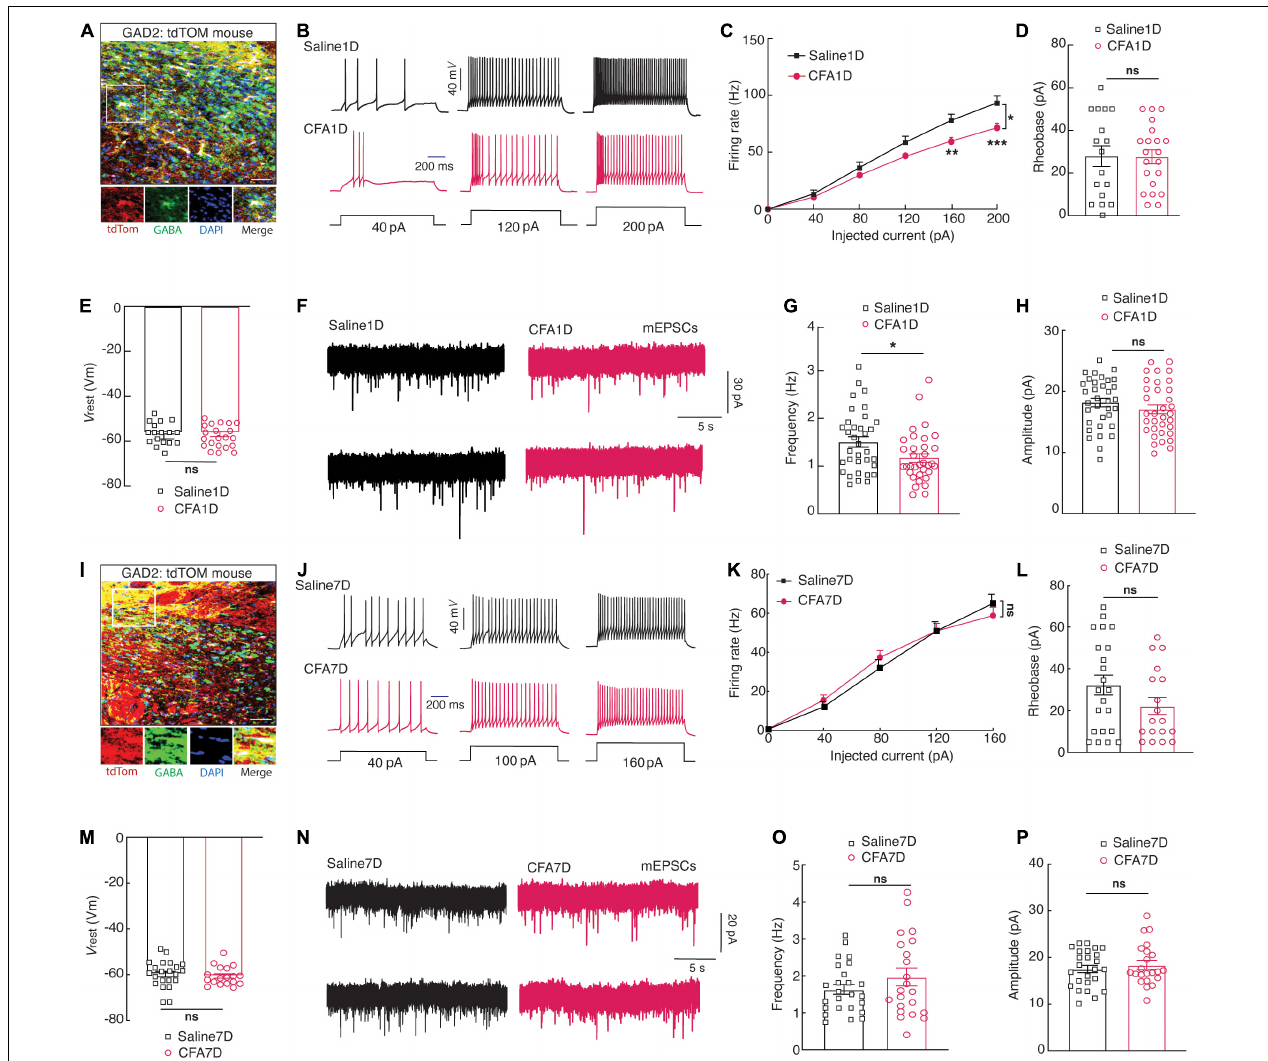
FIGURE 2 | CFA1D mice demonstrate a decrease in the ZI VGABA activity. (A) Confocal images of ZI VGABA from GAD-tdTOM mice. The white box depicts the area shown in the box of the ZI V . Scale bar, 50 µ m. (B) Sample traces and (C) summarized statistical data for action potential firing recorded from ZI VGABA in mice treated with saline1D or CFA1D. Two-way ANOVA with Bonferroni post-tests [Time × group interaction, F (5,180) = 6.735 and P < 0.05]. (D–E) The alterations in action potential properties in (D) , rheobase; t 36 = 0.53 and P = 0.6012; (E) V rest (mV); t 36 = 0.527 and P = 0.6. (F) Sample traces of the mEPSCs from saline1D or CFA1D groups. (G,H) Summarized statistical data of (G) the frequency; t 66 = 2.23 and P = 0.02; (H) the amplitude; t 66 = 1.12 and P = 0.26 of CFA1D compared with saline1D mice. Action potential parameters were estimated from the initial evoked spike. n = 17–36 neurons per group. (I) Confocal images of ZI VGABA from GAD-tdTOM mice. The white box depicts the area shown in the box of the ZI V . Scale bar, 50 µ m. (J) Sample traces and (K) summarized statistical data for action potential firing recorded from ZI VGABA in mice treated with saline7D or CFA7D. Two-way ANOVA with Bonferroni post-tests [Time × group interaction, F (1,21) = 1.403 and P = 0.2495]. (L,M) The alterations in action potential properties in (L) , rheobase; t 38 = 1.558 and P = 0.127; (M) V rest (mV); t 38 = 0.526 and P = 0.6. (N) Sample traces of the mEPSCs from saline7D or CFA7D groups. (O,P) Summarized statistical data of (O) the frequency; t 45 = 1.26 and P = 0.21; (P) the amplitude; t 45 = 0.72 and P = 0.47 of CFA7D compared with saline7D mice. Action potential parameters were estimated from the initial evoked spike. n = 22–25 neurons per group. All data are presented as mean ± SEM. * P < 0.05, ** P < 0.01, and *** P < 0.001; ns, not